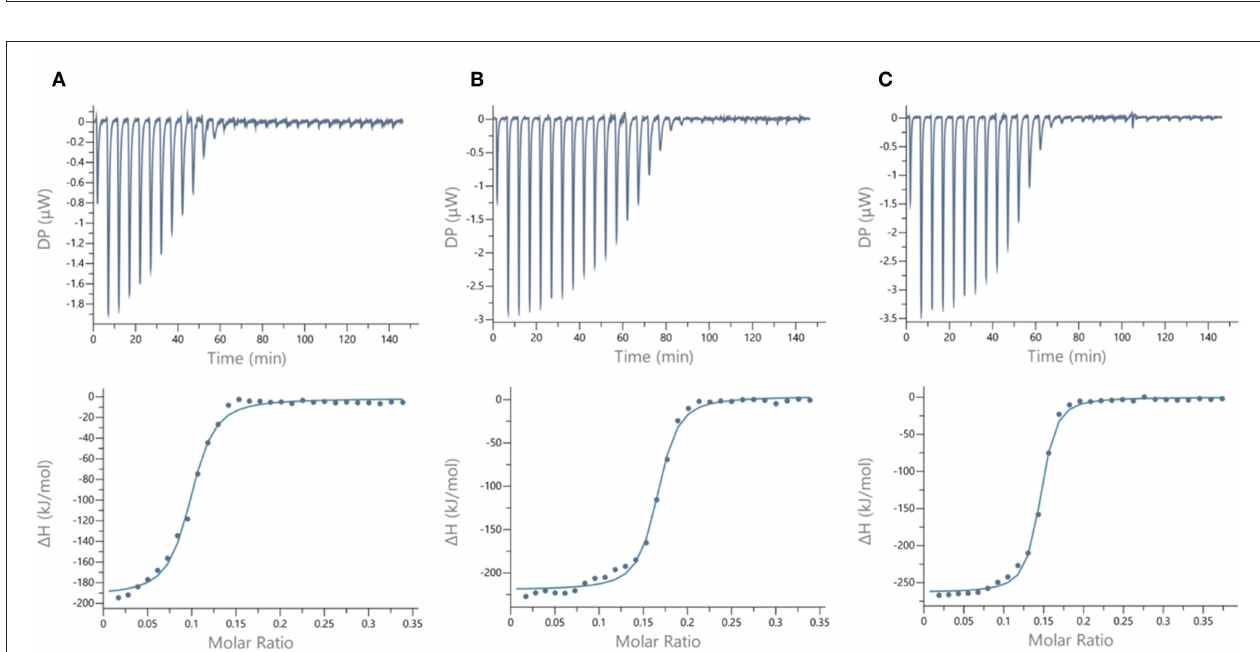
FIGURE 4 | ITC data. Thermograms obtained by injections of (A) glycocluster 16 at 140 µ M in a solution of LecB (70 µ M) and (B) glycocluster 18 at 80 µ M in a solution of LecA (35 µ M) with corresponding integrated titration curves. Molar ratio is indicated as number of glycocluster molecules per lectin monomer.